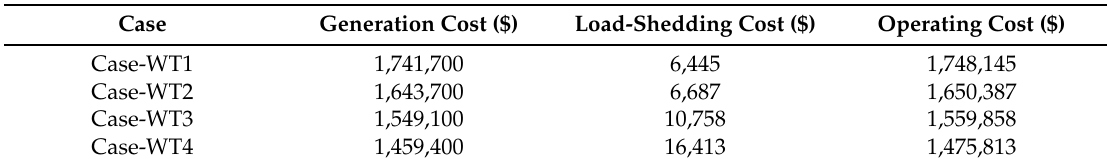
Table 6. Simulated costs for scenarios Case-WT1, Case-WT2, Case-WT3, and Case-WT4.